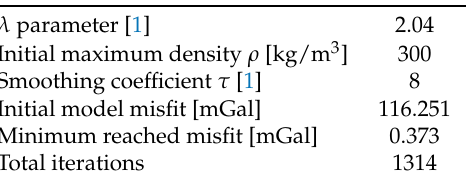
Table 2. Configuration of the gravimetric inversion parameters for the T model.